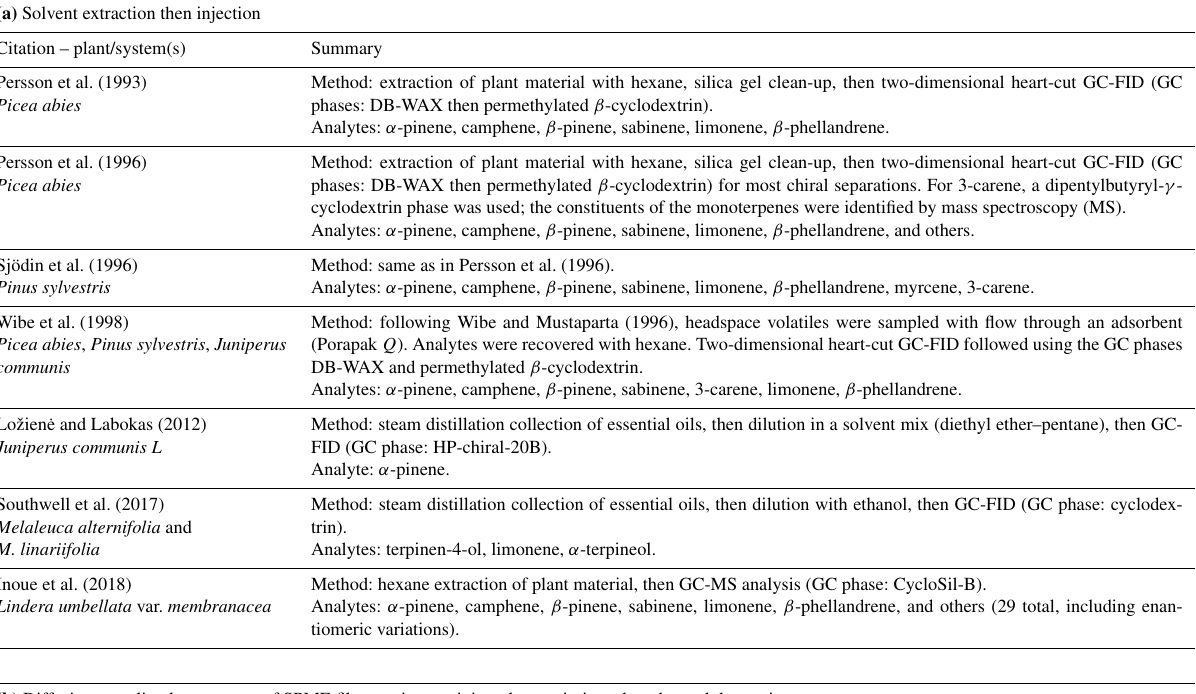
Table 1. Summary of methods used to sample then analyze plant-derived chiral biogenic volatile organic